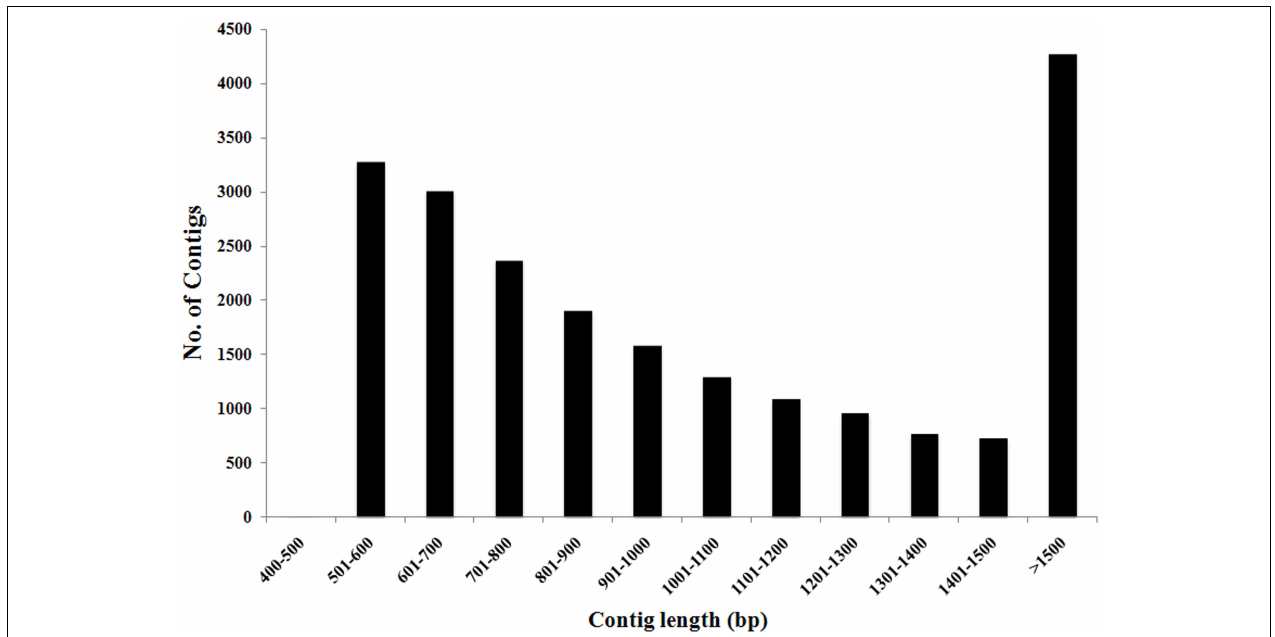
FIGURE 1 | Distribution of total number of V. faba contigs vs. contig length. Most contig lengths were in the range of 500–800bp (50%) and above 1500bp (20%). Total number of contigs decreased as contig length increased.